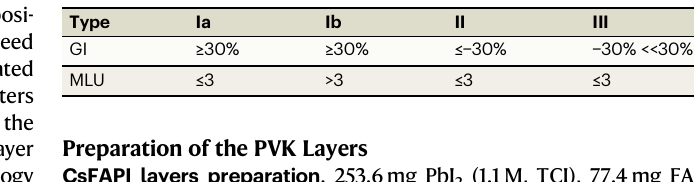
Table 4 | Growth type as a function of the GI and MLU